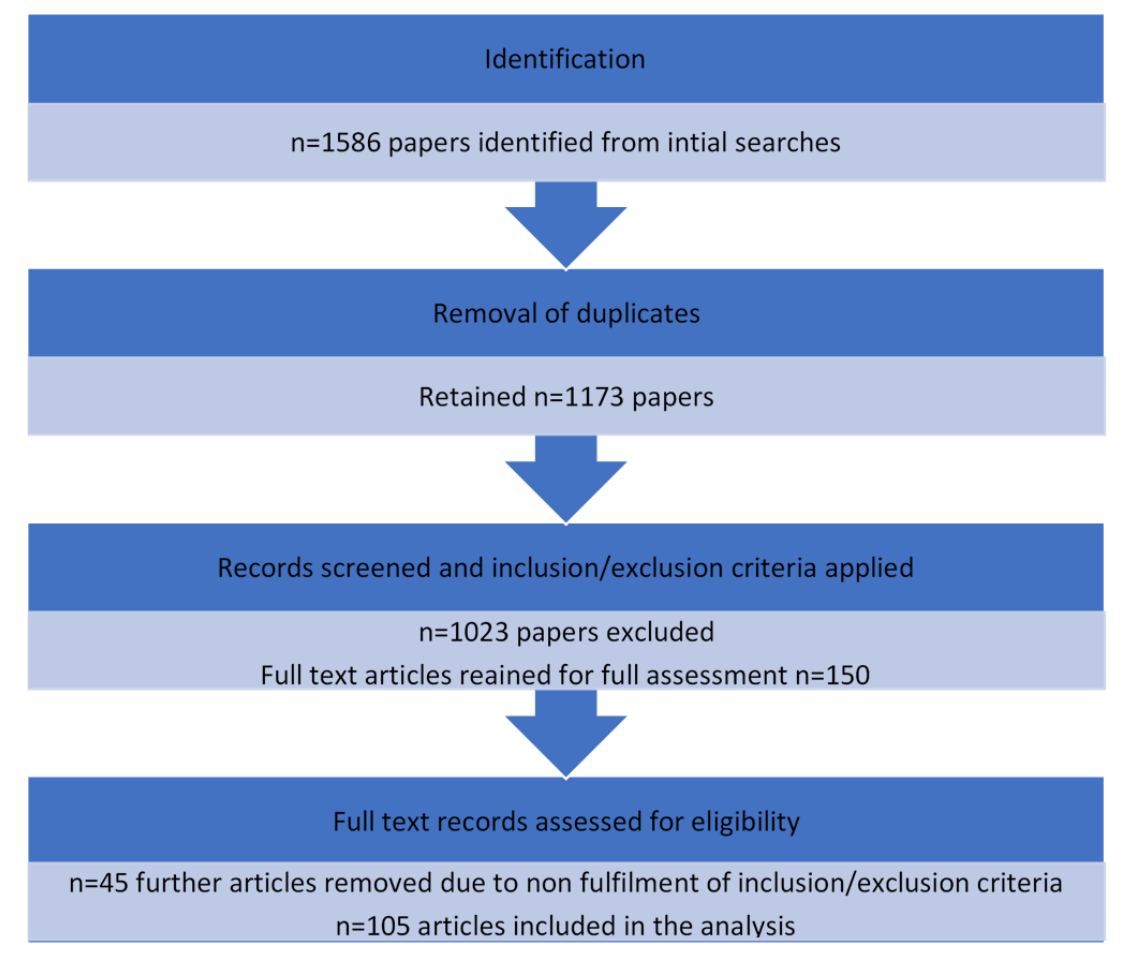
Figure 1. An overview of the process undertaken to identify and review relevant literature for the searches.